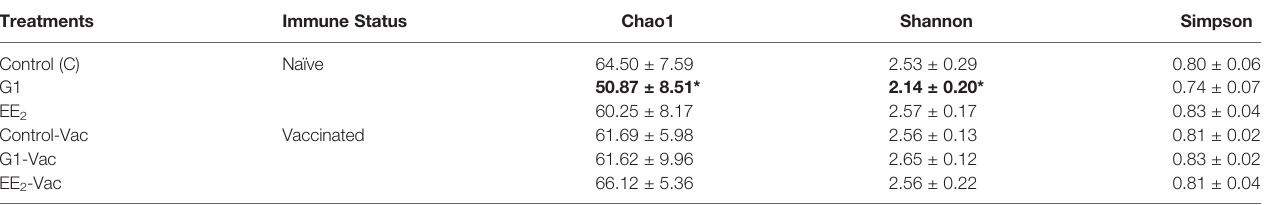
TABLE 2 | Alpha-diversity indices expressed as the richness, diversity, and average evenness (Chao1, Shannon and Simpson) of bacterial communities present in the hindgut of gilthead seabream (n=6 fi sh per condition) treated with G1 or EE 2 (5 m g/g food) for 43 days either immune primed or not with KLH on the previous day ’ s (24 h)